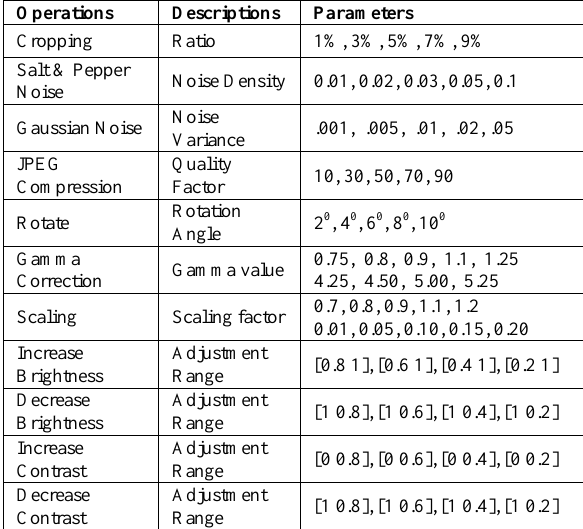
Table 1. Various operations with parameter values.